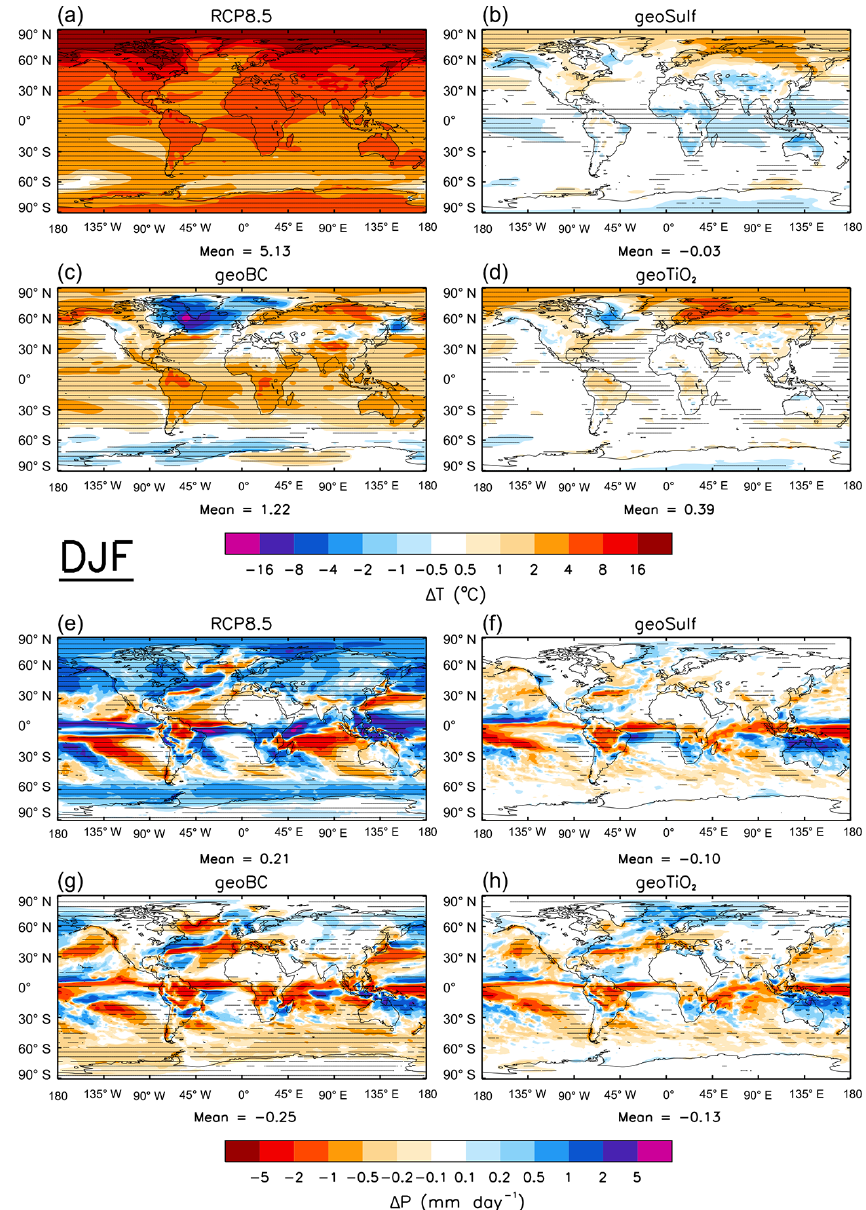
Figure 8. DJF near-surface air temperature (top) and precipitation rate (bottom) anomalies with respect to